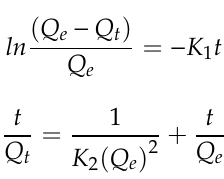
Figure 8. Adsorption kinetic curves of ANT on Hal, Hal-350, Hal-450, Hal-550 and Hal-CNT composites.